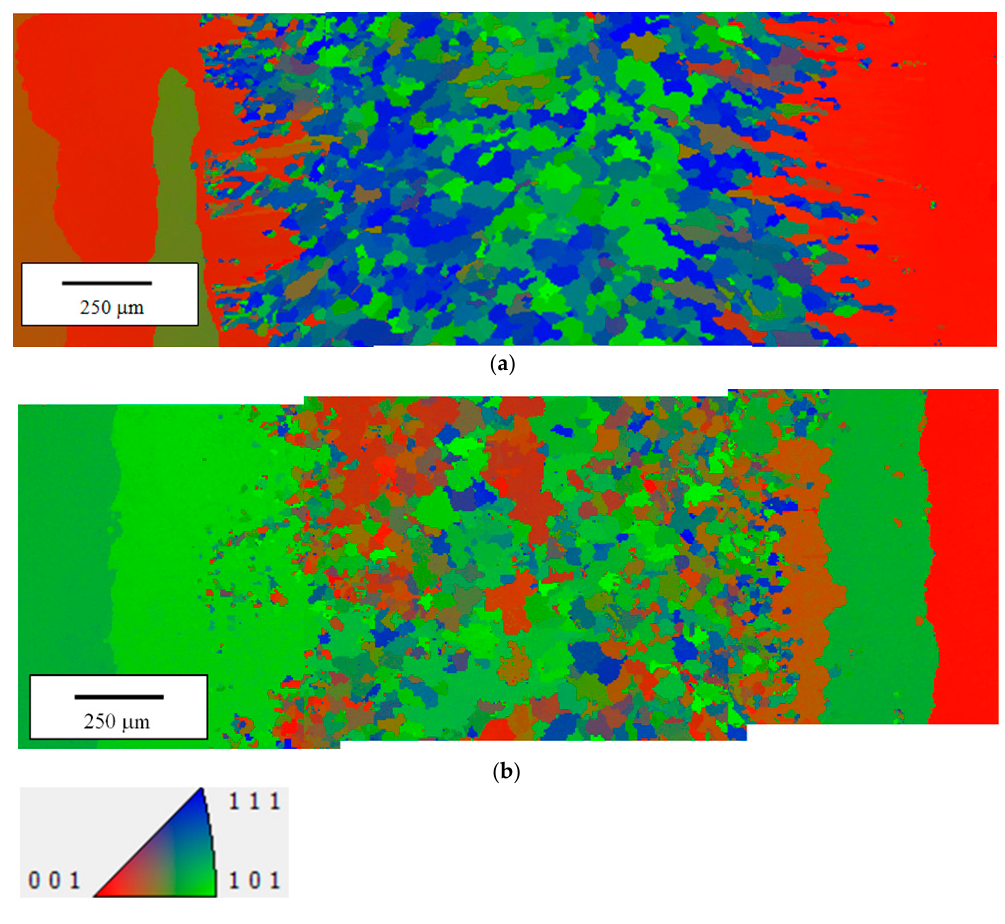
Figure 12. Electron back-scattering diffraction (EBSD) maps collected from joints realized with PHT = 300 °C and pass speeds v = 1.5 m/min ( a ) and v = 2.0 m/min ( b ).